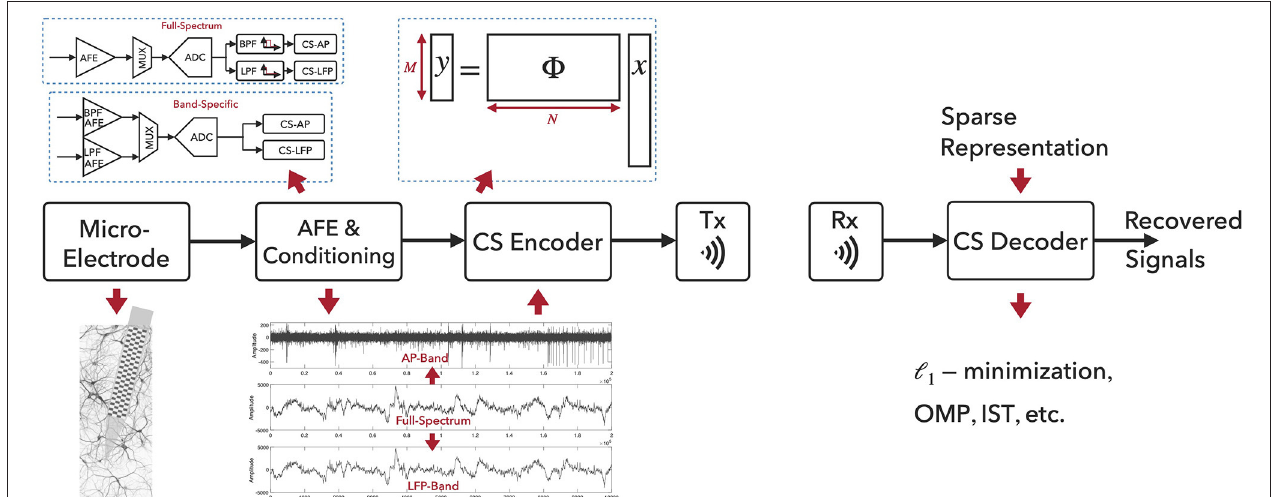
FIGURE 1 | Compressed sensing based neural recording architecture and signal processing